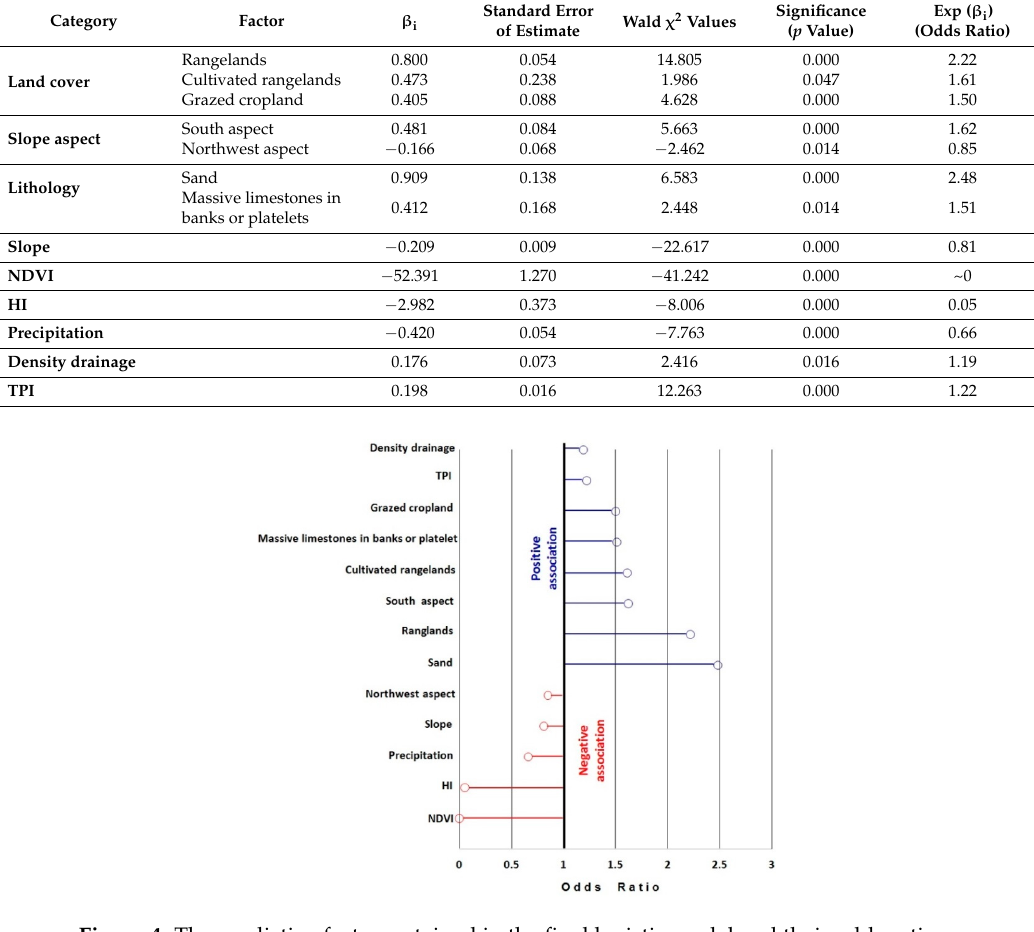
Table 4. The predictive factors retained in the final logistic model and their estimated coefficients. Table 3. Pseudo R 2 Test of the logistic model with 13 predicting factors.